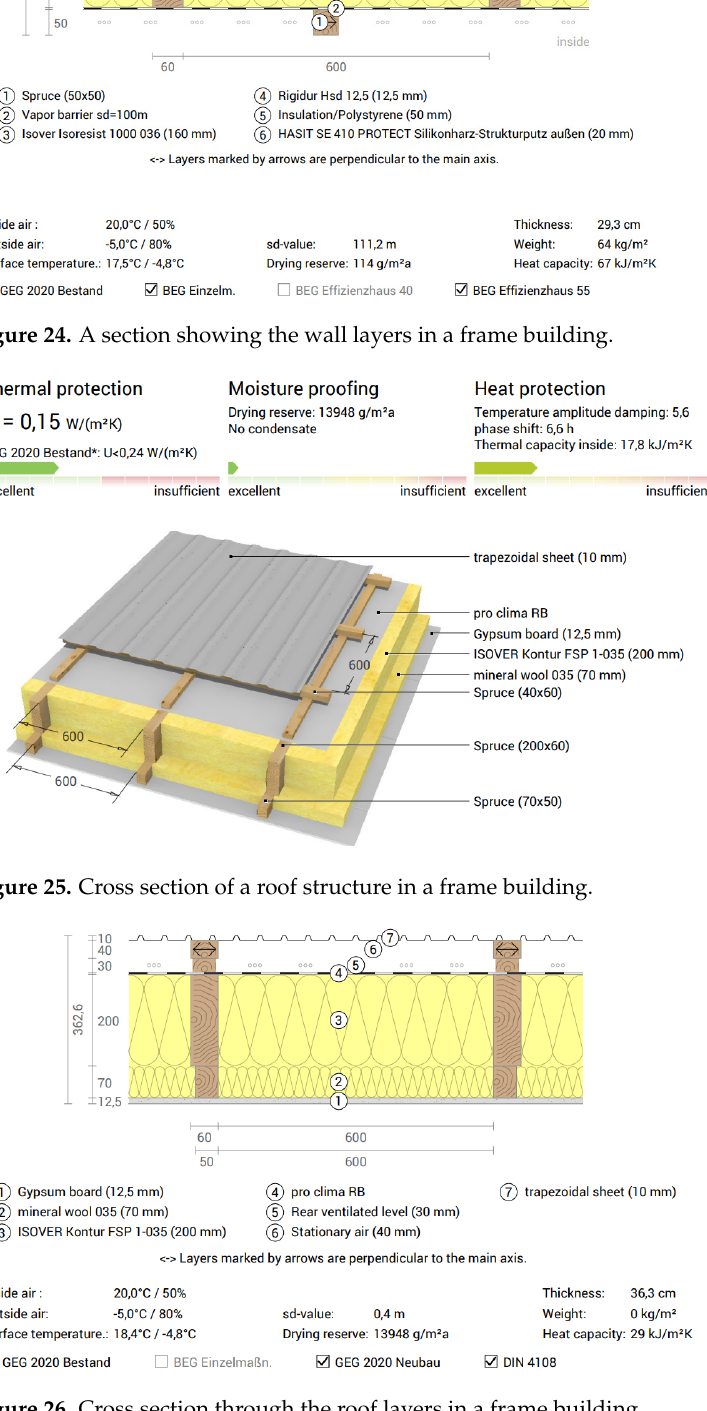
Figure 26. Cross section through the roof layers in a frame building.